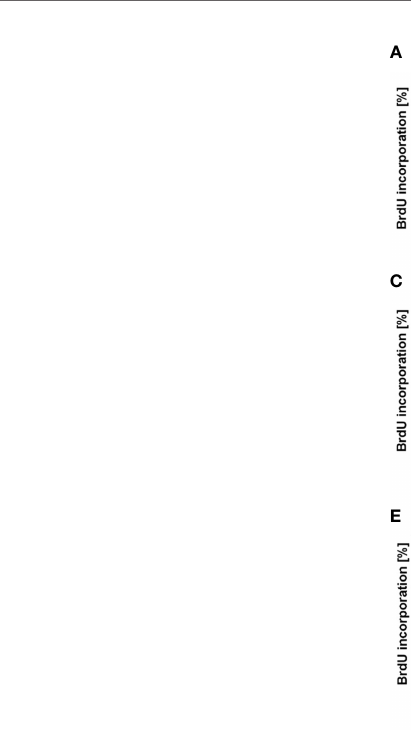
FIGURE 2 | Tumor cell proliferation of parental (par) and DX-resistant (res) DU145 (A, B) , PC3 (C, D) , and LNCaP (E, F) cells incubated for 48 h with ART [37.5 and 50 µM]. Untreated controls were set to 100%. Error bars indicate standard deviation (SD). Signi fi cant difference to untreated control: ***p ≤ .001. n =